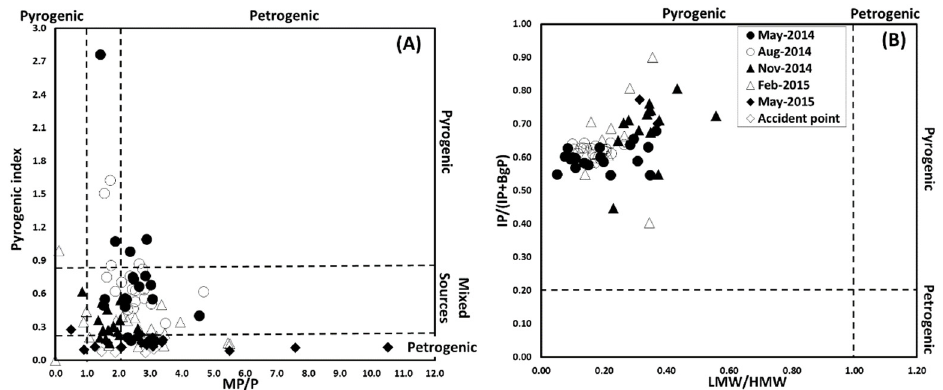
Figure 4. Plots of calculated ( A ) MP/P versus pyrognic index. ( B ) LMW/HMW versus IP/(IP + BgP)